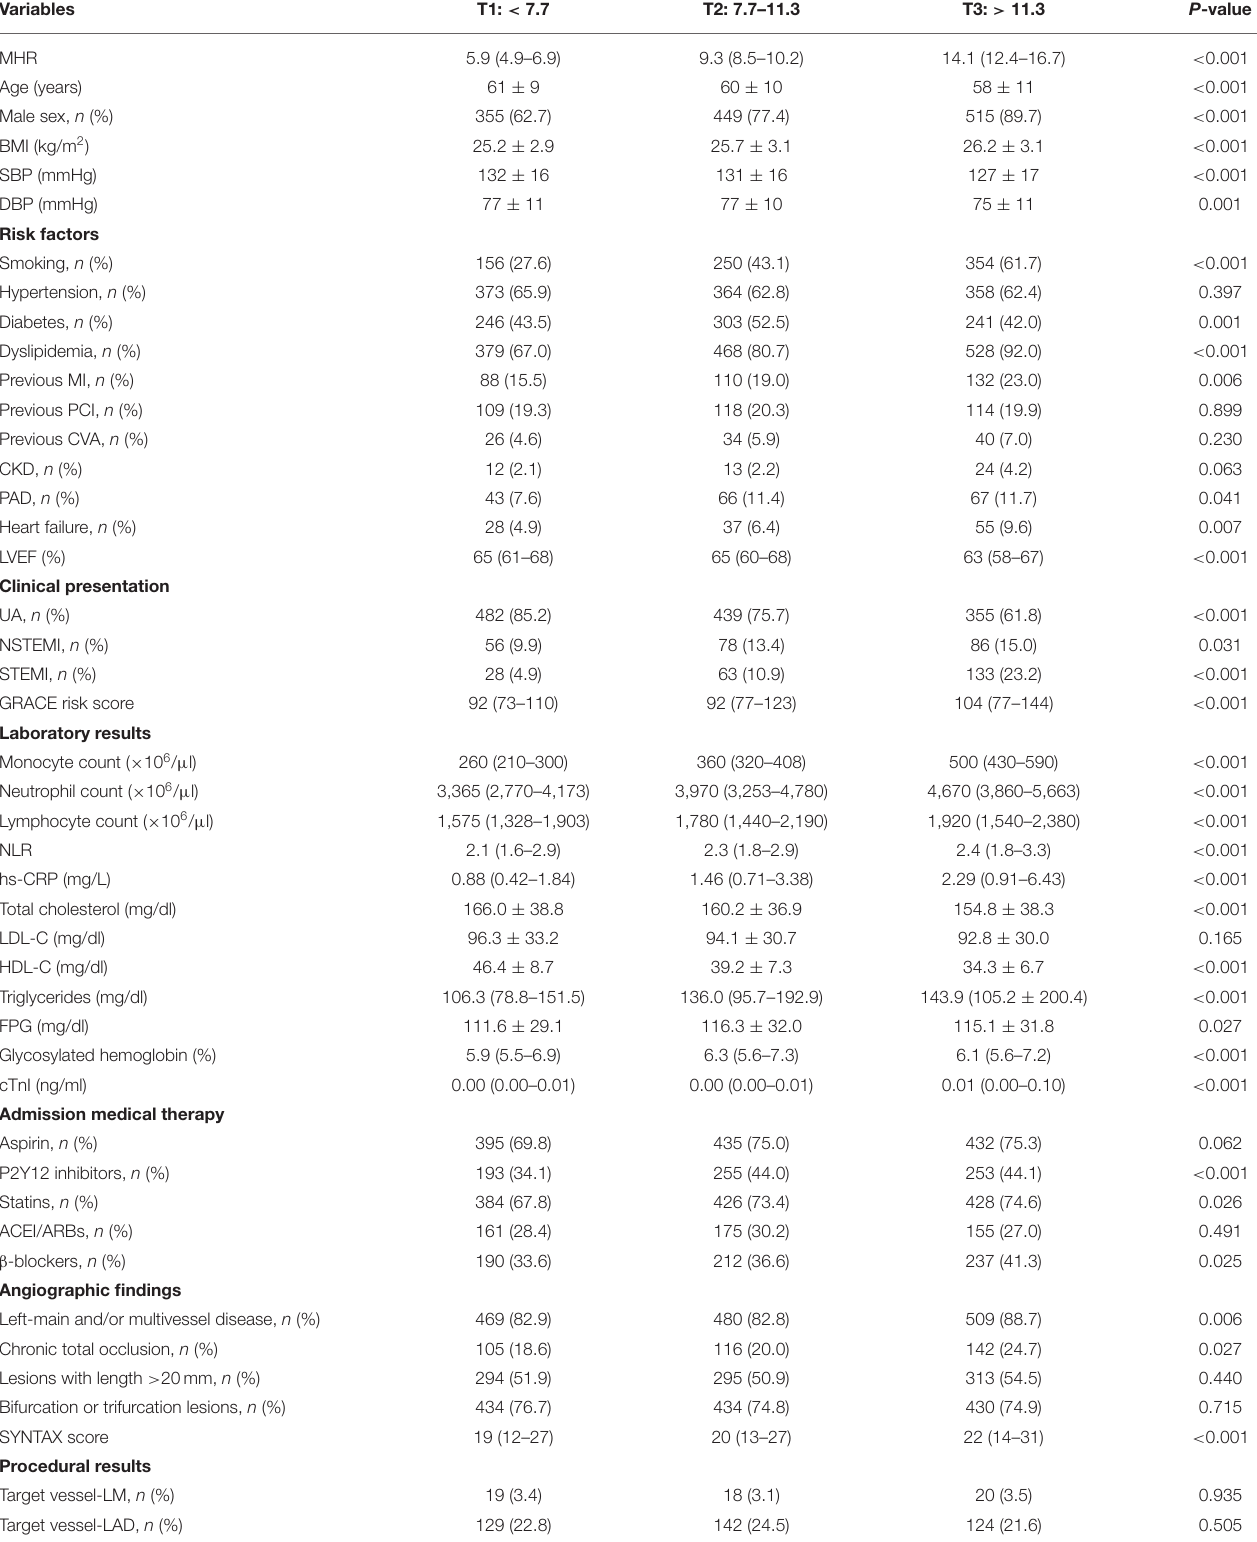
TABLE 1 | Baseline characteristics of the study population according to the MHR tertiles.